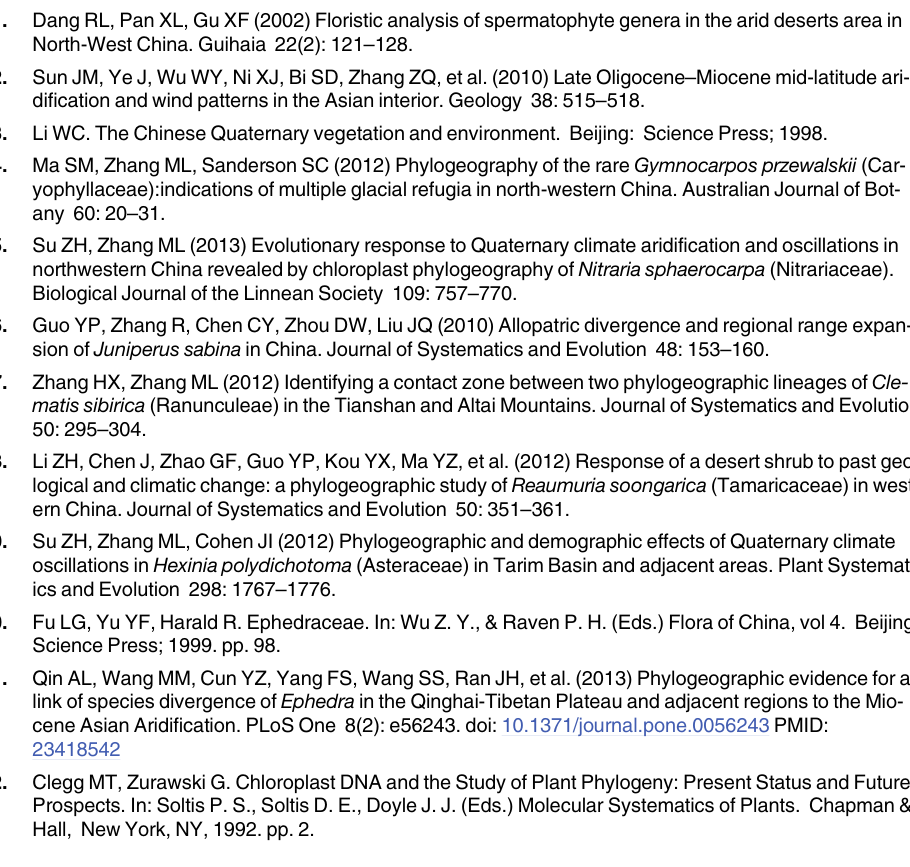
S1 Table. Details of sample locations, sample size, and haplotype frequencies for 45 popula- tions of Ephedra przewalskii . Figures in the parenthesis represent the number of the haplo- types. S2 Table. Sixteen haplotypes of Ephedra przewalskii recognized on basis of two chloroplast DNA sequences, trn H — psb A and trn T – trn